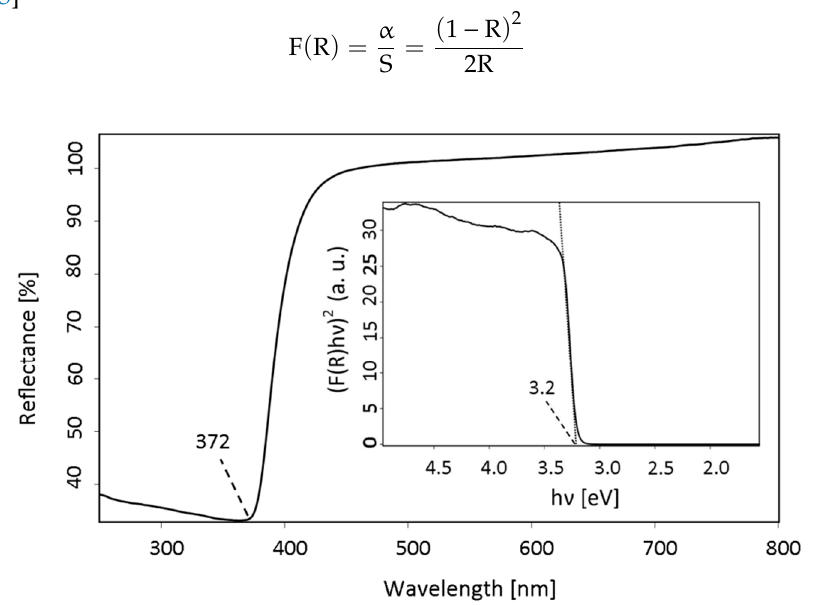
Figure 8. UV–vis DRS spectrum of ZnO type B powder with the inserted plot of K-M function vs. photon energy.